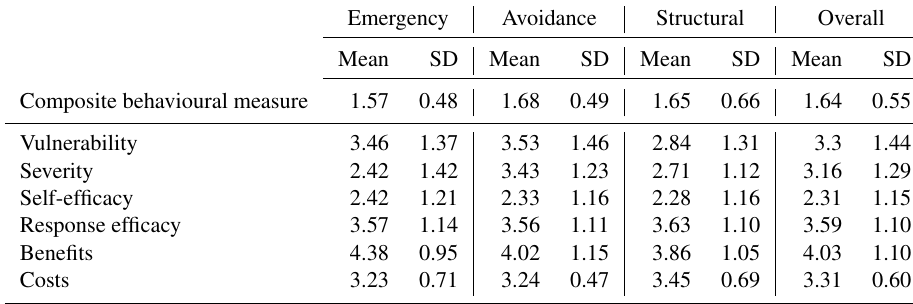
Table 3. Descriptive statistics of variables used in the dynamic protection motivation